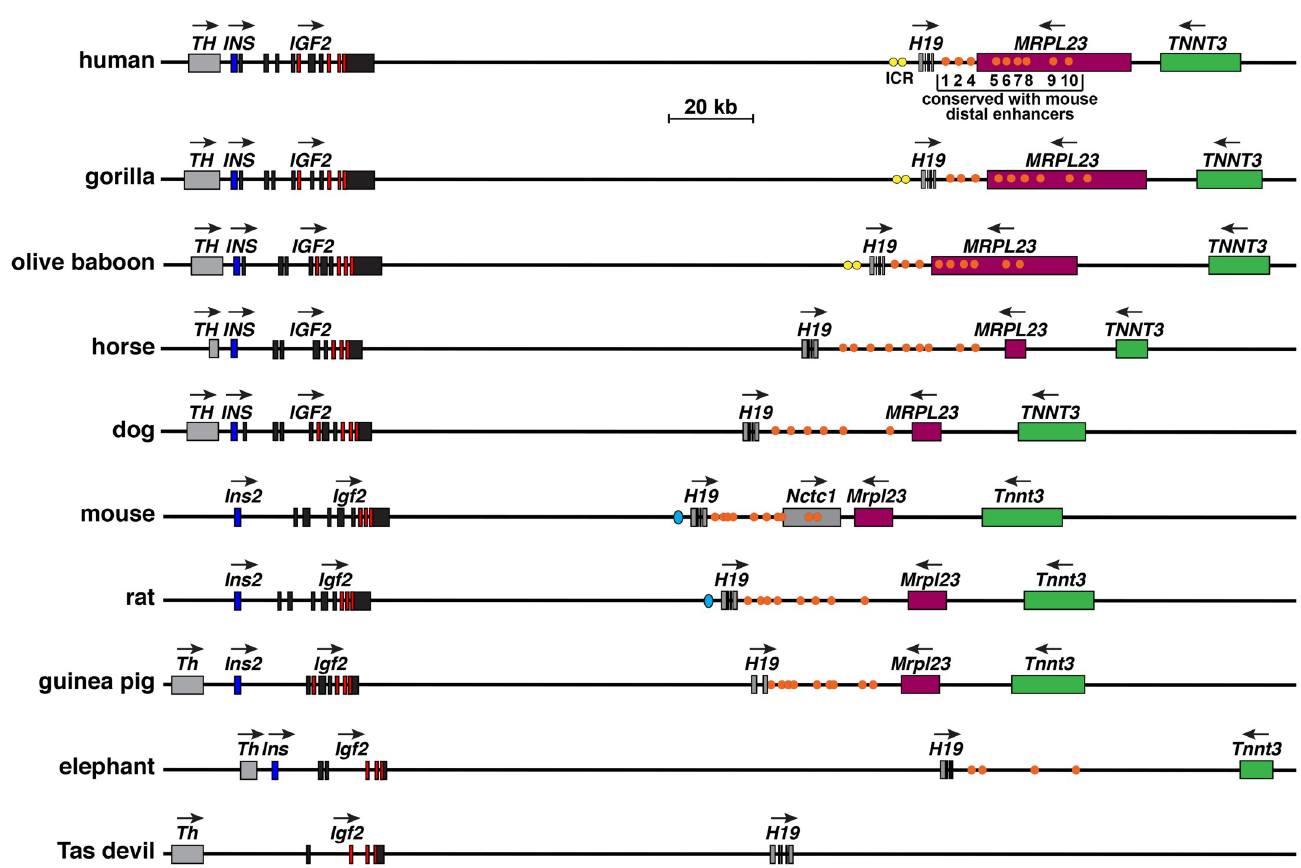
Fig 10. Comparison of IGF2/Igf2 — H19 locus and genes in mammals. Diagrams of human, gorilla, olive baboon, horse, and dog IGF2—H19 , and mouse, rat, guinea pig, elephant, and Tasmanian (Tas) devil Igf2—H19 genes and loci are shown. For IGF2/Igf2 and H19 , individual exons are indicated as boxes (coding regions are in red). Other genes are shown as single boxes, and include the following: tyrosine hydroxylase ( TH/Th ), insulin ( INS/Ins2 ), noncoding RNA Nctc1 (mouse only), mitochondrial ribosomal protein L23 ( MRPL23/Mrlp23 ), troponin T3, fast skeletal type ( TNNT3/Tnnt3 ). A horizontal arrow indicates the direction of transcription for each gene. Yellow (primate) or aqua ovals (mouse and rat) depict the imprinting control region (ICR) 5’ to H19 , and orange circles indicate homologues of the 10 distal enhancers that were identified and functionally mapped in the mouse genome [40], and identified by DNA sequence similarity in the other genes (see Table 4). A scale bar is also shown. Th is not illustrated on the maps for mouse or rat, as it is separated from Ins2 by ~226 Kb (mouse), and by ~222 Kb (rat).